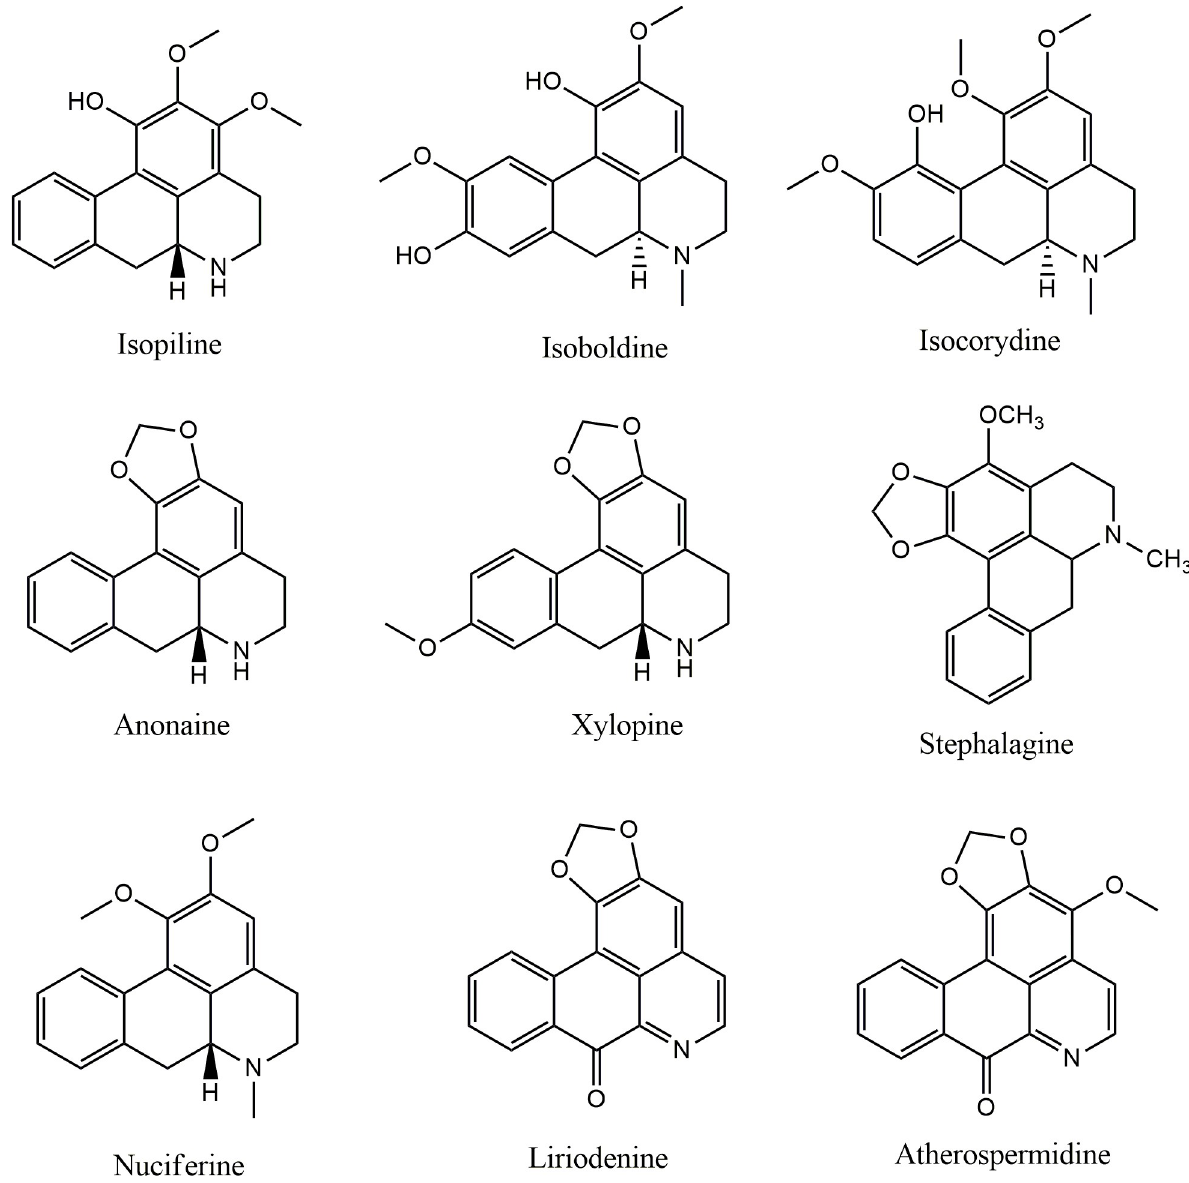
Fig 2. Chemical structures of the aporphine alkaloids identified in the AF-Ac fraction from A . crassiflora fruit